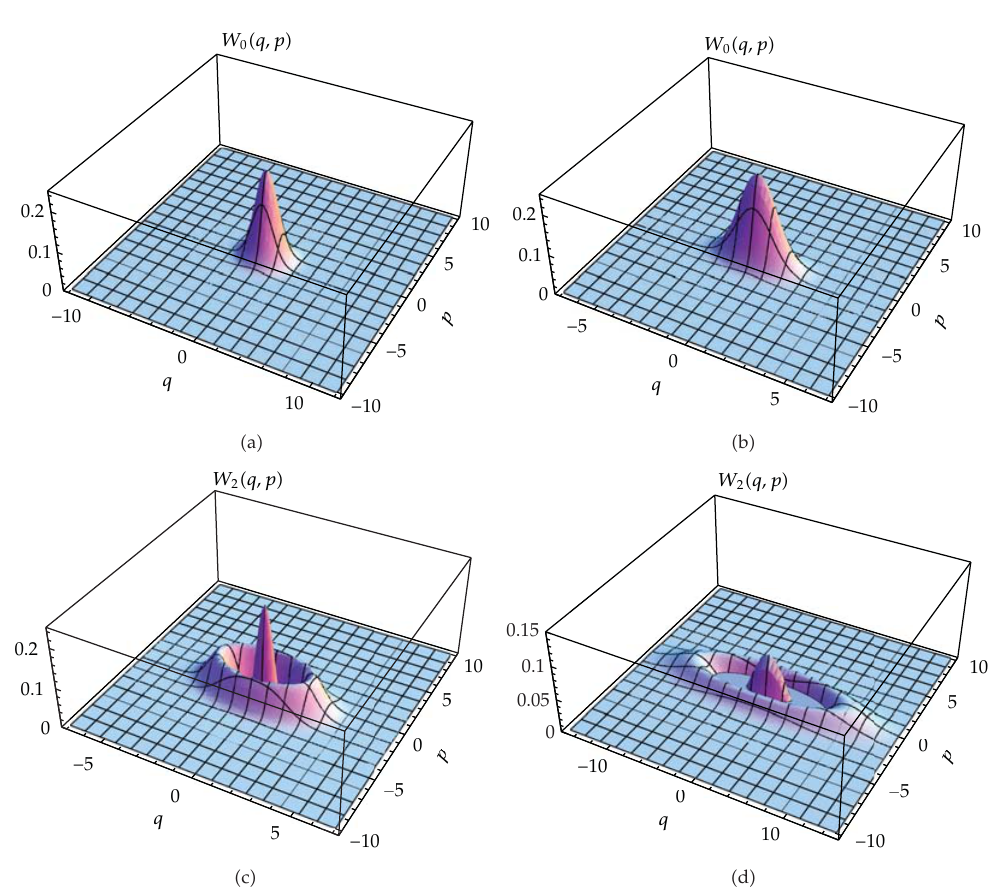
(cid:20) t ω (cid:5)(cid:8)(cid:4) 0.1, 0.005 (cid:5) ; (cid:4) c (cid:5) | 2 (cid:4) for t 0